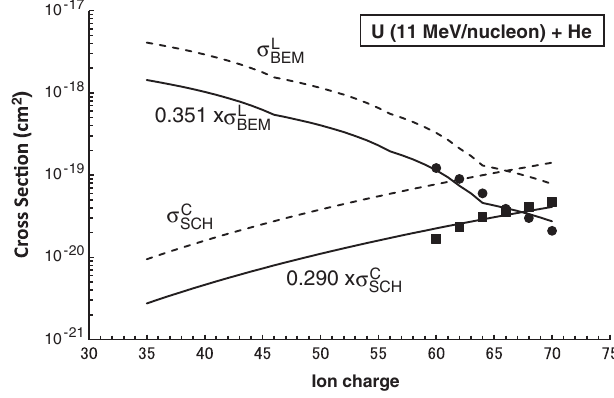
FIG. 6. Cross sections used for simulation of charge evolution of uranium ions in He gas at 11 MeV = nucleon along with thickness. The dotted lines show the calculated cross sections and (cid:2) C ) using the binary of e-loss and e-capture ( (cid:2) L BEM SCH encounter model and Schlachter’s formula. The solid lines show the scaled cross sections by 0.351 and 0.290 for e-loss and e-capture, respectively, in order to fit to the measured cross sections. The circles and squares denote the measured cross sections of e-loss and e-capture,